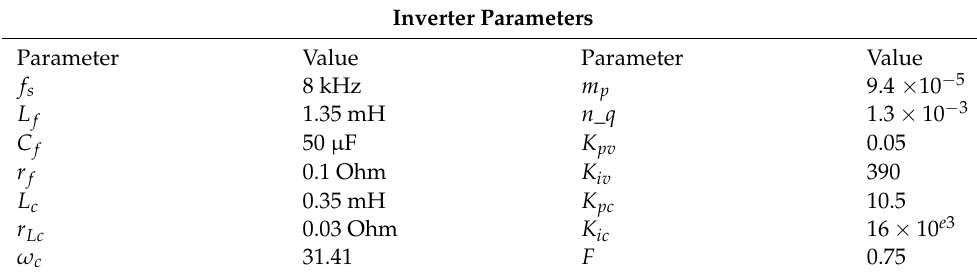
Figure 5. Case study: microgrid topology. Table 2. Microgrid parameters.